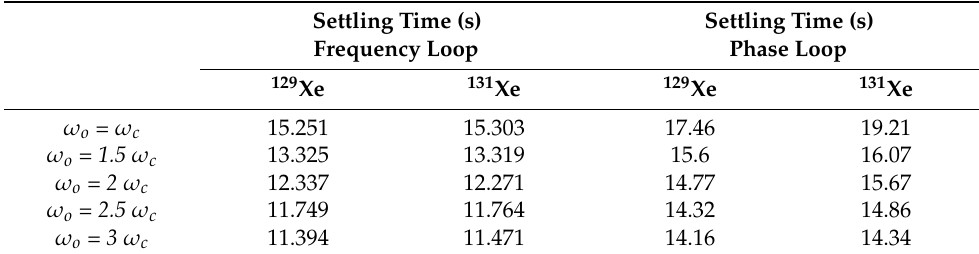
Figure 6. Experimental results of increasing bandwidth of the LESOs. ( a , c ) are the performance of the 129 Xe, and ( b , d ) are the loop of 131 Xe. Both kinds of isotopes were driven synchronously, and the influence of the parameter ω o was specified. Table 2. Detailed Settling Time of the Tested Method in Figure 6.